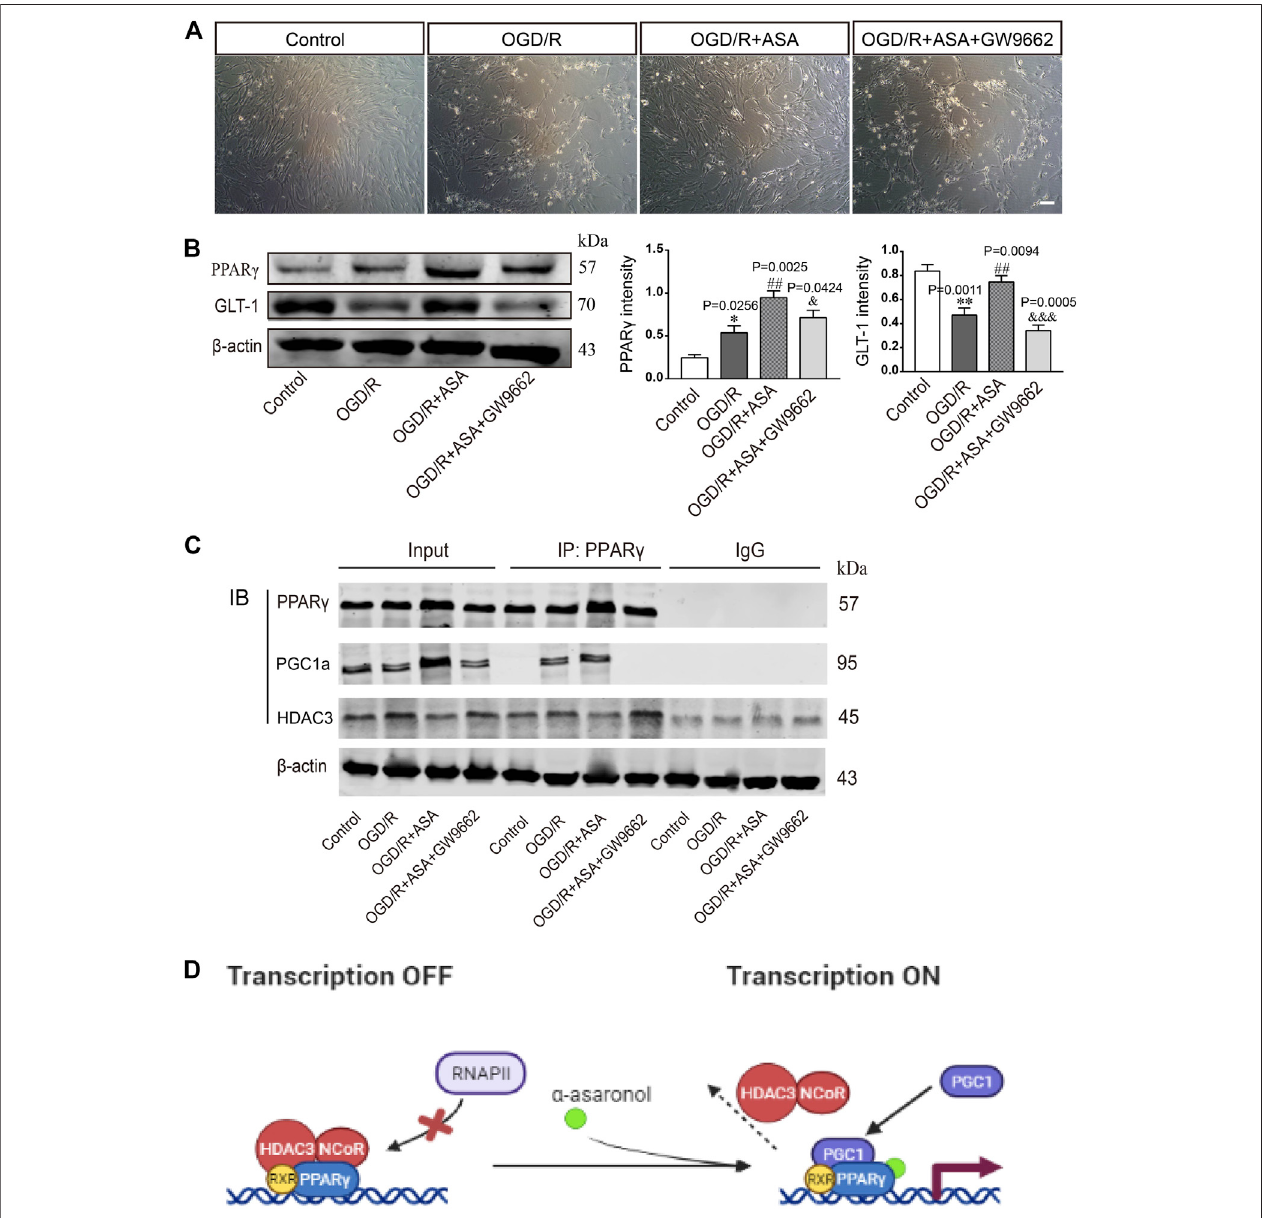
FIGURE 7 | α -Asaronol upregulated GLT-1 expression in astrocytes by activating PPAR γ . (A) The morphology of astrocytes under the bright fi eld. Scale bar, 50 µm. (B) The expression of PPAR γ and GLT-1 was detected by western blotting. PPAR γ and GLT-1 were quanti fi ed and normalized against β -actin. (C) Co-IP was used to examine the interaction of PPAR γ and PGC1a or PPAR γ and HDAC3. (D) Graphical image representing the ligand-independent repression and α -asaronol- dependent transactivationofPPAR γ . All dataare representedasthe mean ±SEM. * p < 0.05, ** p < 0.01vs. controlgroup, ## p < 0.01 vs. OGD/Rgroup, & p < 0.05, &&& p < 0.001 vs. OGD/R + ASA group. N = 4 for each